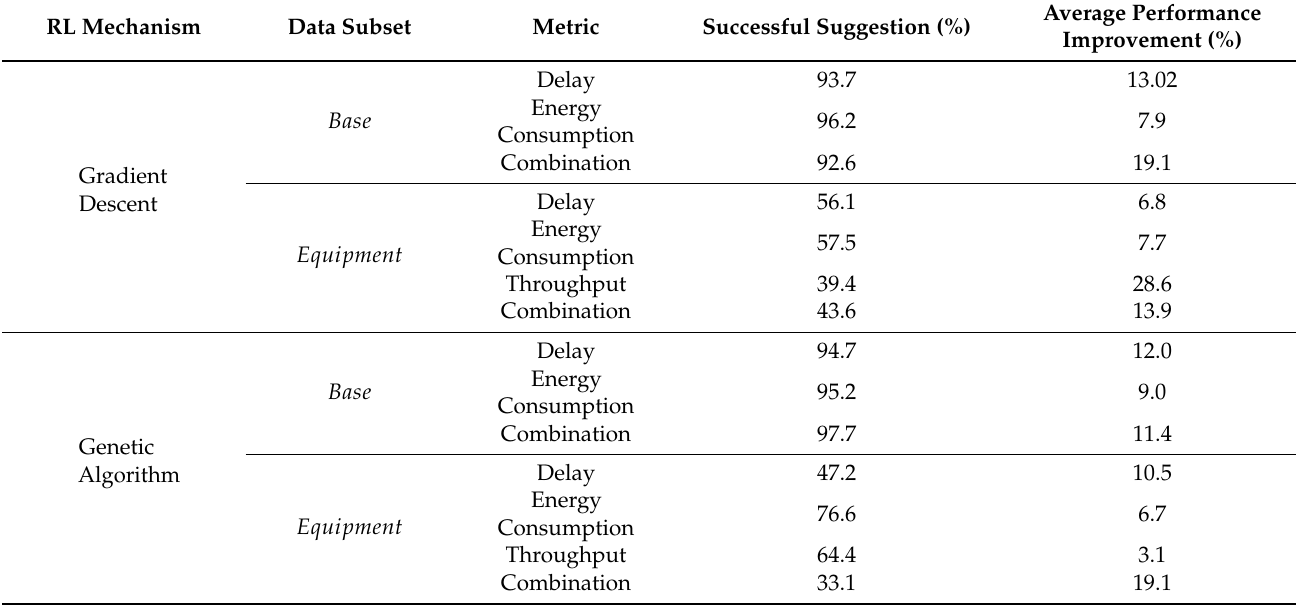
Table 7. Successful improvement and suggestion percentage shown for every performance metric with its respective data subset and the RL approach taken. Where the successful suggestion percentage stems from the suggested configuration compared to the original on the test